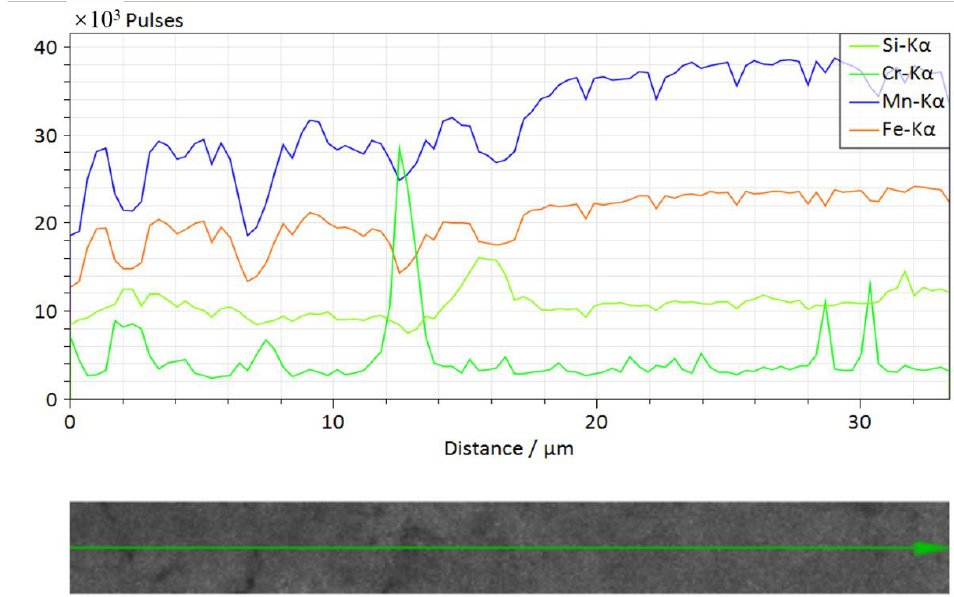
Figure 10. EDS line scanning results in the shells of polymetallic nodules. (The direction of the arrow represents the direction of polymetallic nodule growth.).